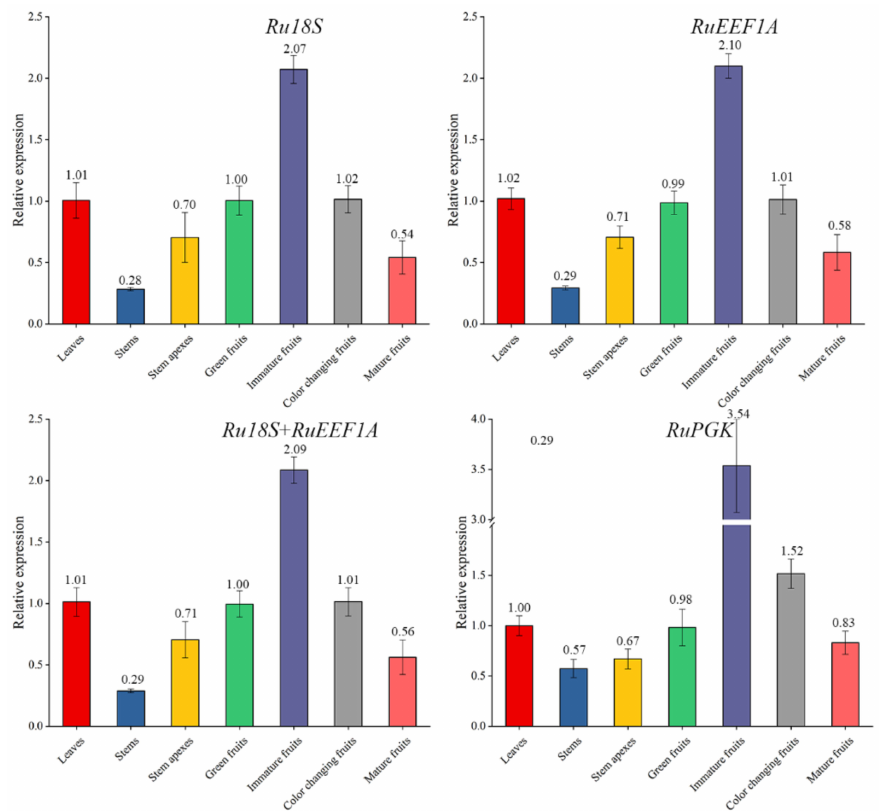
Figure 5. Expression patterns of RuCYP73A normalized to the top two stable genes ( Ru18S and RuEEF1A ) and an unstable gene ( RuPGK